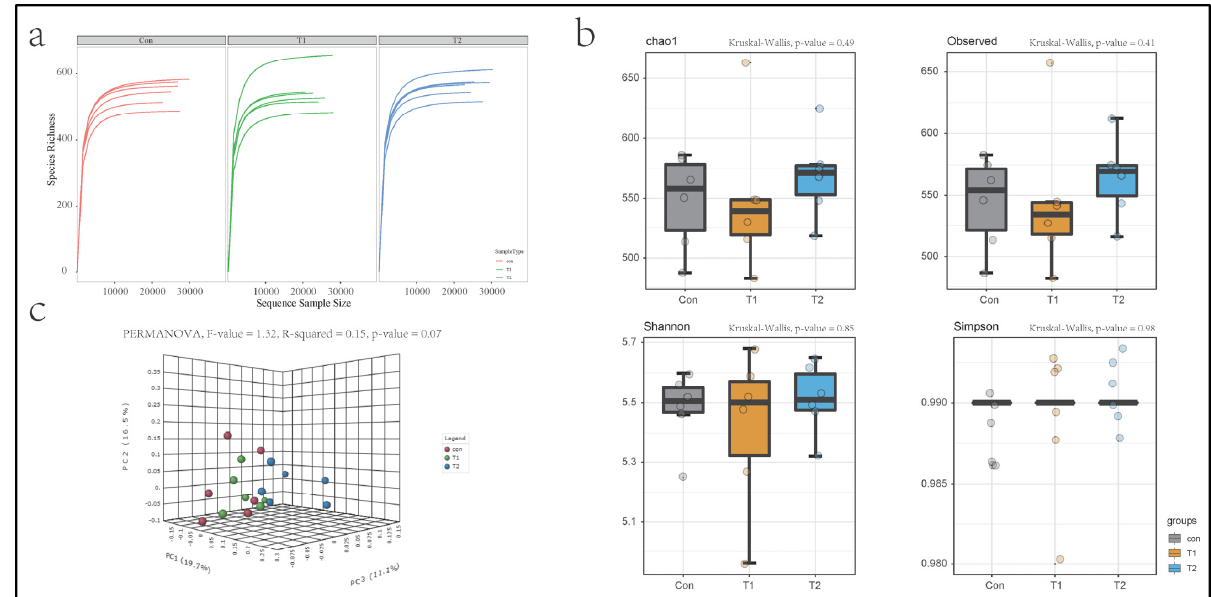
Figure 1. The overall description of the gut microbiota in different groups. ( a ) The observed species dilution curve evaluated the rationality of the sequencing depth. ( b ) The α -diversity of microbial communities is shown as richness and evenness. ( c ) The principal coordinate analysis of the ileal microbial community.